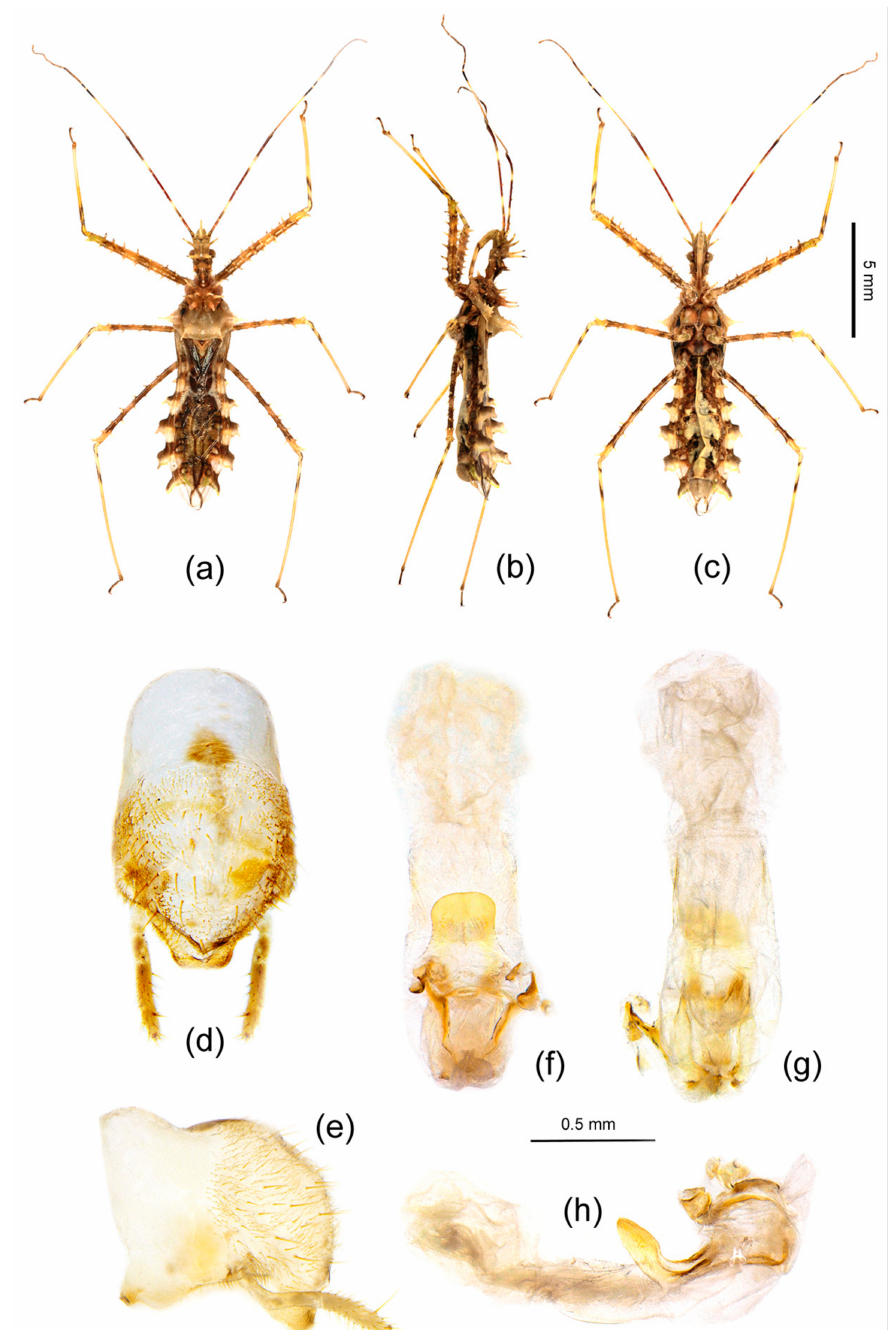
Figure 10. Sclomina parva sp. nov., ( a – c ) male, SXYX, habitus; ( d – h ) male external genitalia. ( d , e ) py- gophore with paramere; ( f – h ) phallus. ( a , f ) dorsal view; ( b , e , h ) lateral view; ( c , d , g ) ventral view. Scale bar of ( a – c ) = 5 mm, ( d – h ) = 0.5 mm. Measurements (males ( n = 3), in mm): Body length 12.73 ± 0.03; maximal width of abdomen 4.47 ± 1.18. Head length 3.15 ± 0.1; length of anteocular part 1.13 ± 0.06; length of postocular part 1.31 ± 0.13; length of synthlipsis 0.67 ± 0.09; distance between ocelli 0.55 ± 0.01; length of antennal segments I–IV = 5.66 ± 0.65: 2.96 ± 0.28: 1.55 ± 0.39: 2.76 ± 0.68; length of visible rostral segments I–III = 1.06 ± 0.15: 1.43 ± 0.04: 0.44 ± 0.13; length of pronotum 2.47 ± 0.1; maximal width of pronotum 4.21 ± 0.32; length of heme- lytron 8.05 ±